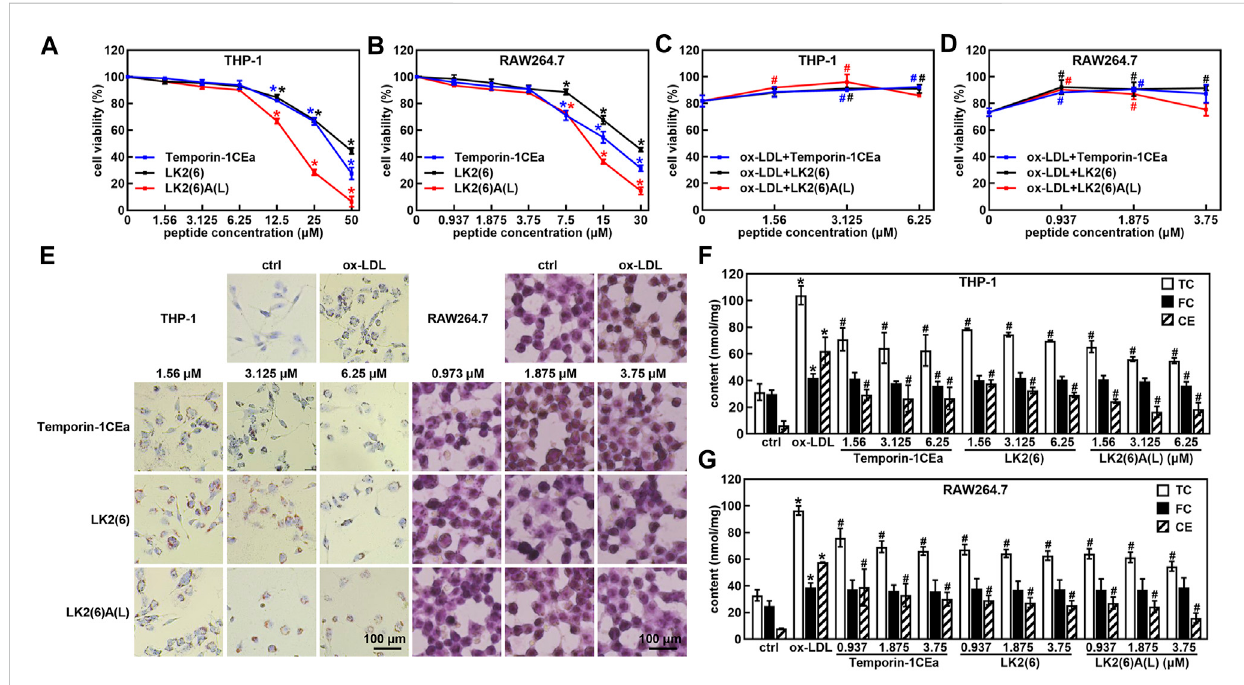
FIGURE 2 Effects of frog skin AMPs on ox-LDL induced foam cells. Effects of frog skin AMPs on the cell viability of THP-1 cells (A) , RAW264.7 cells (B) and ox- LDL induced foaming cells (C,D) ; Cell morphological changes and lipid droplet formation analyzed by ORO staining ( E , 400X); Levels of total cholesterol (TC), free cholesterol (FC) and cholesterol ester (CE) in the frog skin AMPs treated foam cells (F,G) . * p < 0.05 vs. the ctrl group. # p < 0.05 vs. the ox-LDL